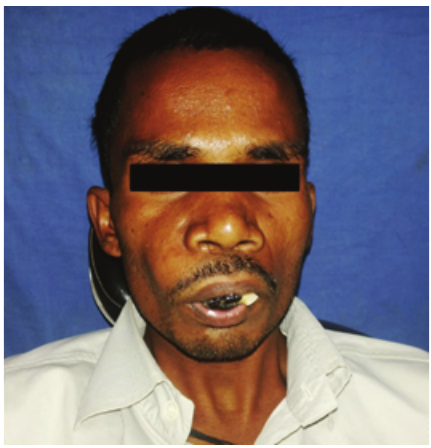
Figure 1: Incompetent lips with blackish growth.